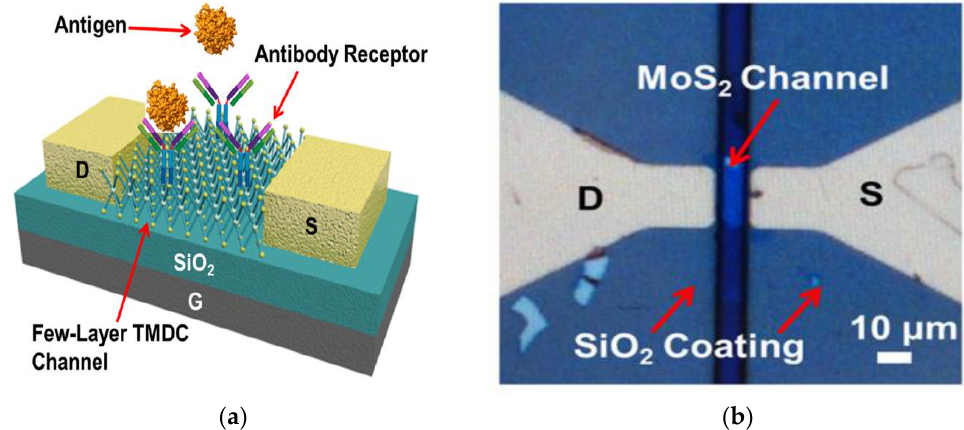
Figure 3. ( a ) Schematic sketch of FET biosensor with antigen-antibody binding. ( b ) Optical micrograph of MoS 2 FET biosensor. Reproduced from [46] with the permission of AVS: Science & Technology of Materials, Interfaces and